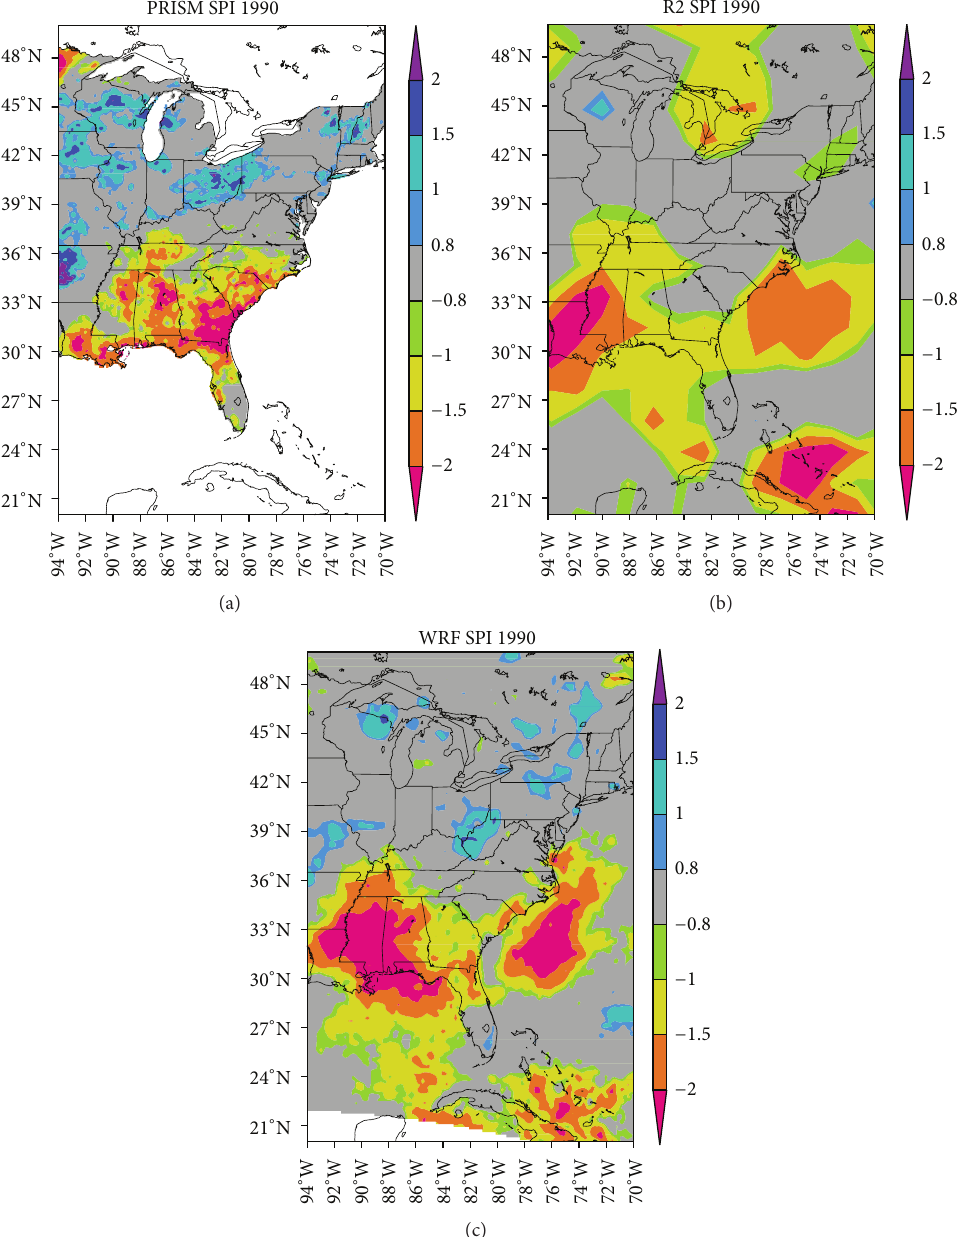
Figure 7: 6-month SPI for the period ending in September 1990 calculated from (a) PRISM, (b) R2, and (c) WRF.